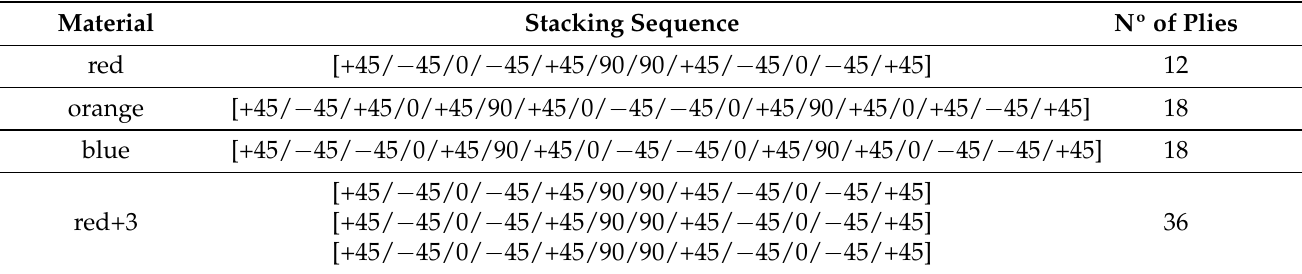
Table 1. MILANO unmanned aerial vehicle (UAV)